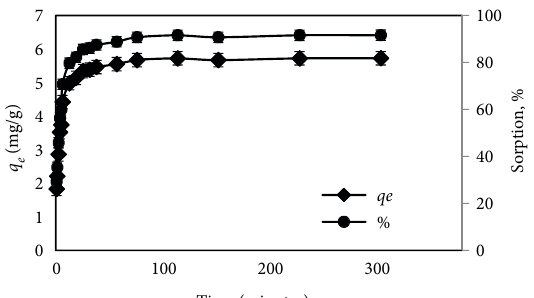
Fig. 5. Variation of biosorption capacity and yield with contact